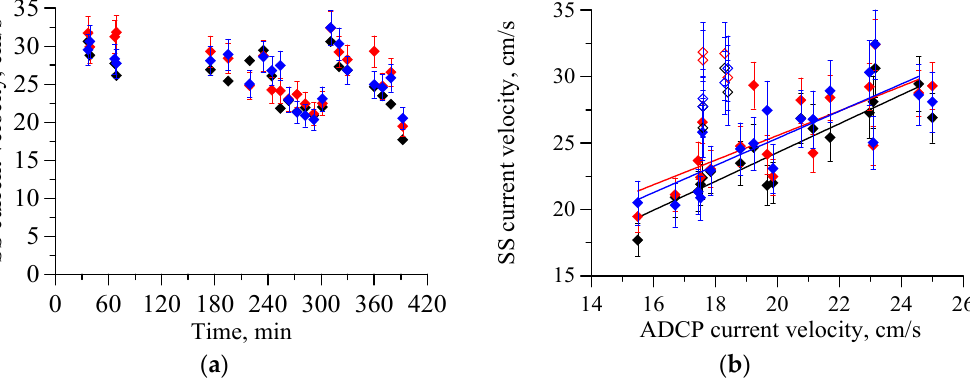
Figure 5. ( a ) Time series of the subsurface current velocities. ( b ) Subsurface current velocity vs. ADCP current velocity at a depth of 1 m. Case study 4.1. Black dots—S-band, red—C-band, blue—X-band. Solid symbols-wind speed 7–3 m/s; open symbols-8–9 m/s.